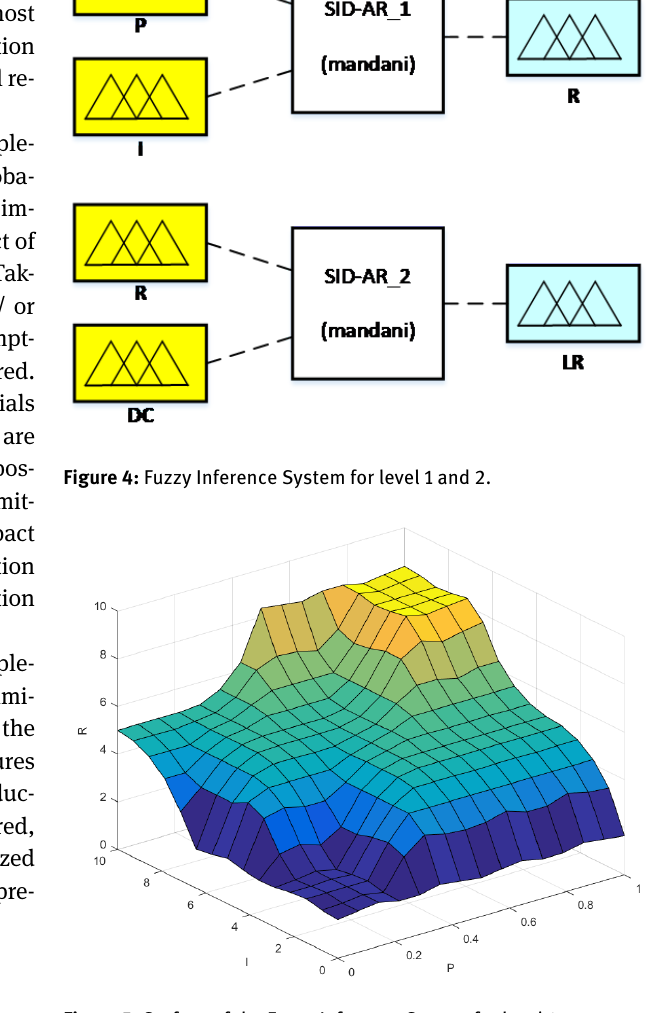
Figure 5: Surface of the Fuzzy Inference System for level